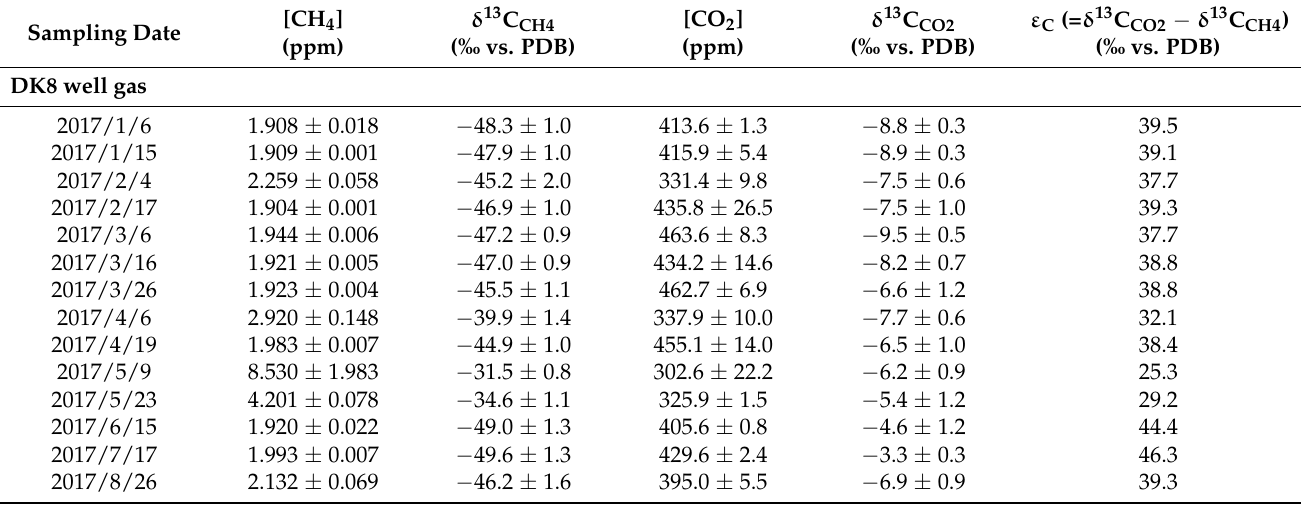
Table 1. Methane content and carbon isotopic compositions of methane and carbon dioxide in the gas effused from the DK8 hydrate gas drilling well and in the free gas of the soil active